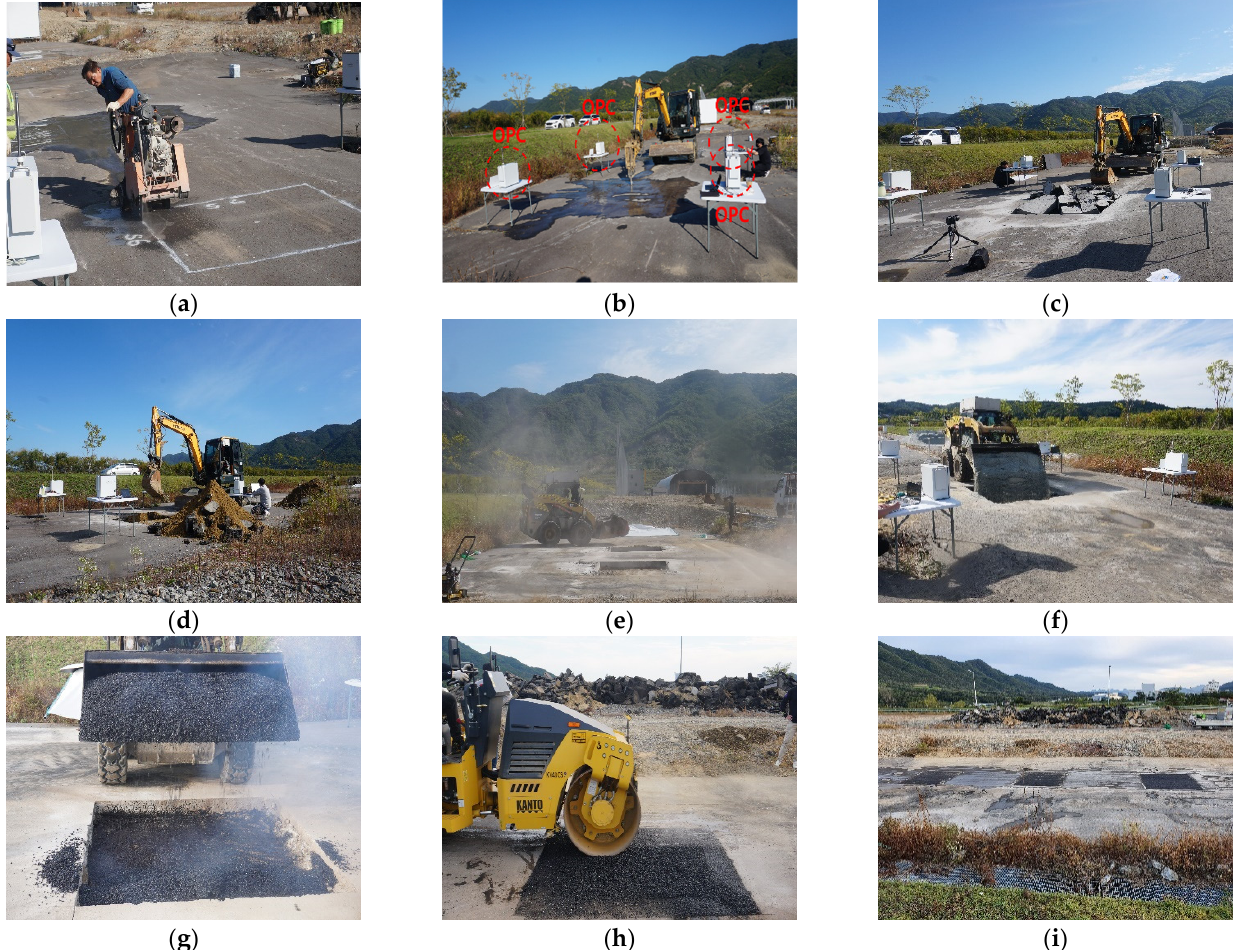
Figure 3. First field test. ( a ) Cutting, ( b ) breaking, ( c ) removal, ( d ) excavation, ( e ) site sweeping, ( f ) restoration, ( g ) asphalt laying, ( h ) compaction, and ( i ) completed asphalt pavement (sections 4–6).